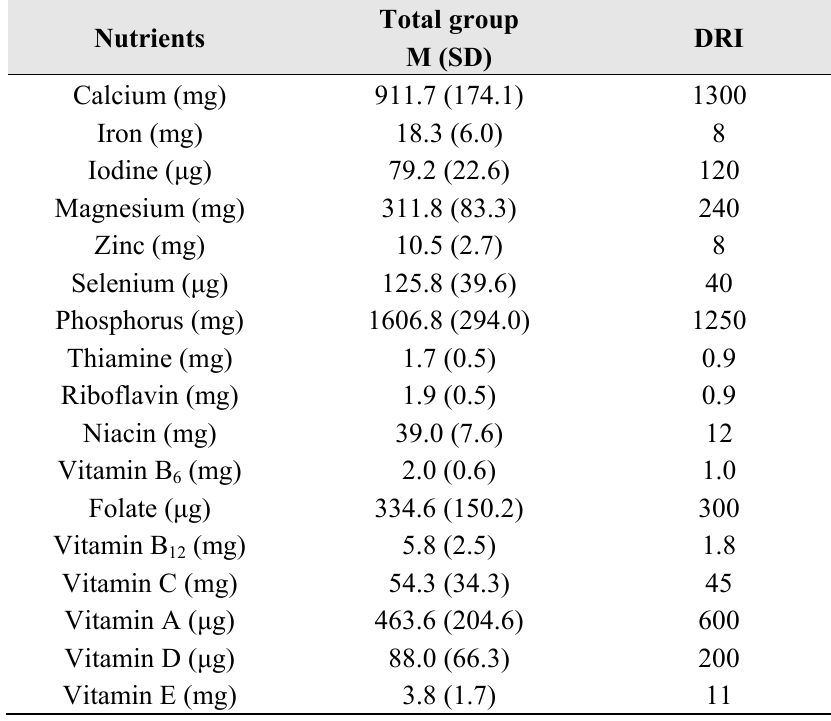
Table 3. Mineral and vitamin daily intake.